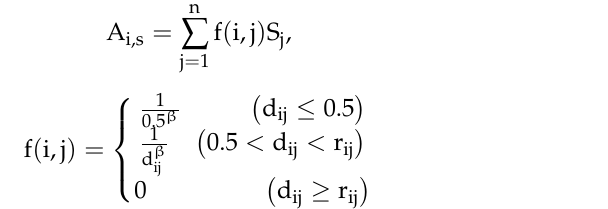
Table 1. Public service facilities by classification.